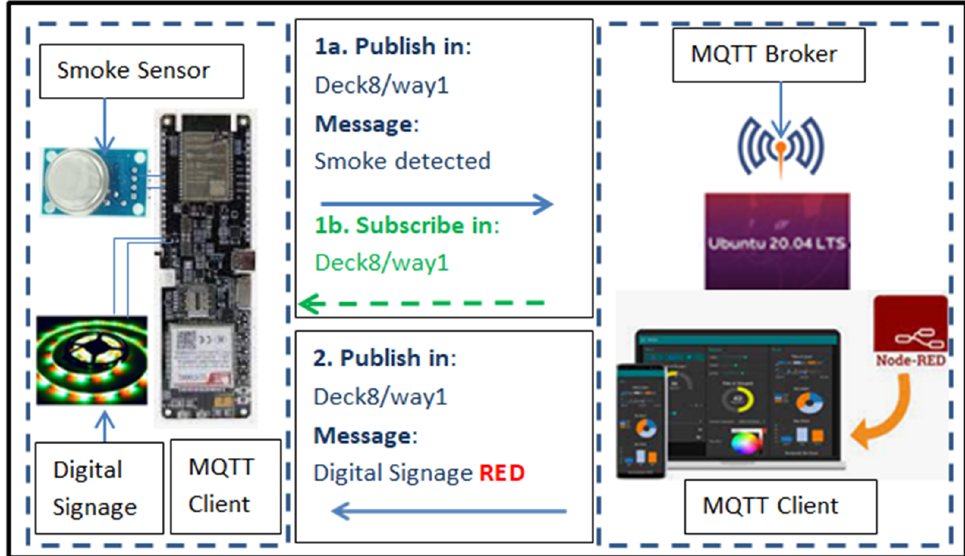
Figure 12. Digital signage scalability example .